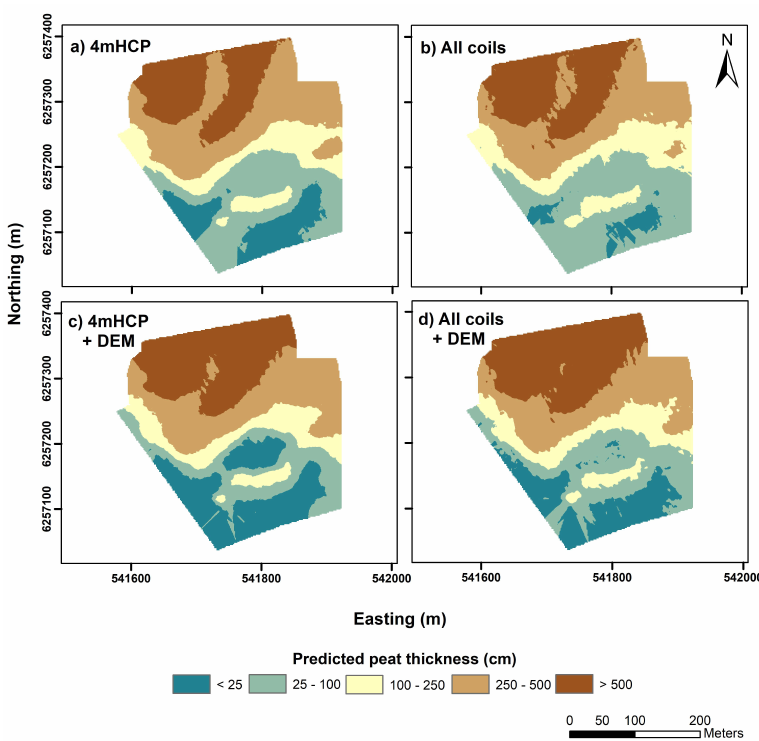
Figure 13. Contour plots of the interpolated peat thickness (cm) predicted from ( a ) 4mHCP, ( b ) the combination of all six coils, ( c ) the combination of 4mHCP and the DEM and ( d ) the combination of all six coils and the DEM.